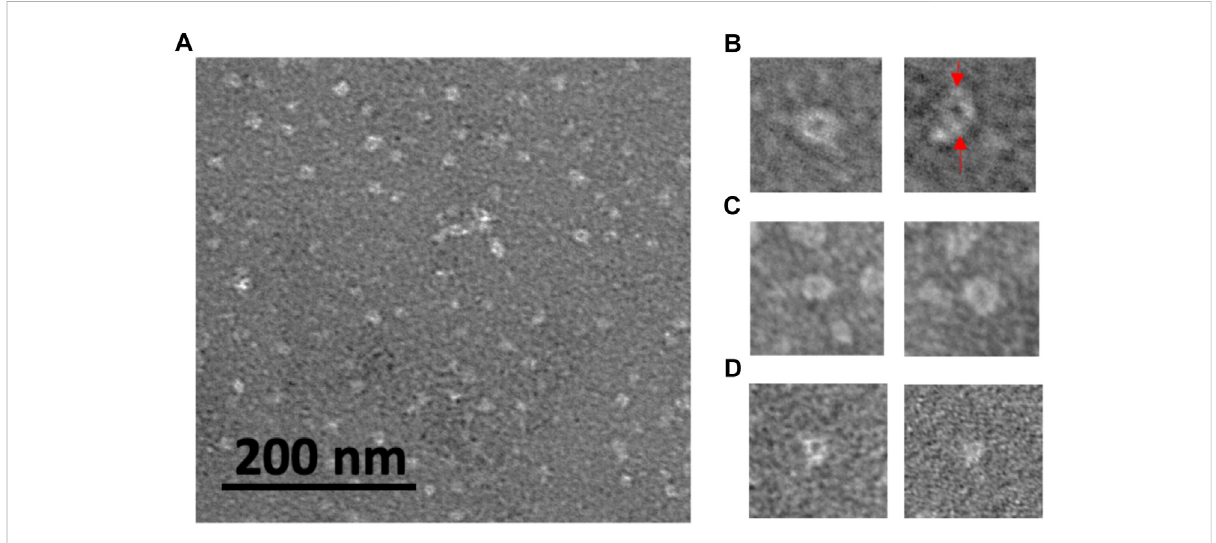
FIGURE 4 TEM images of protein oligomers adsorbed onto grids for (A) rpM179; select images of oligomer rings for (B) rpM179 (arrows point to individual dimers), (C) H3, and (D) H8. The widths of the frames in (B – D) are 50